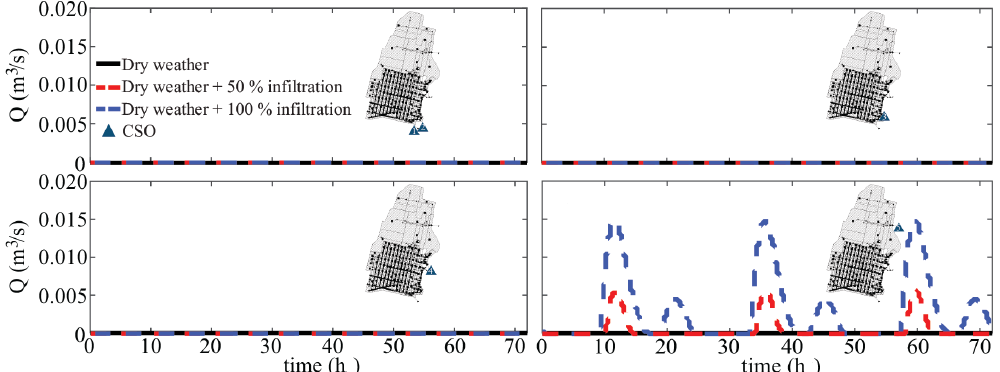
Figure 11. Flow rate as function of time at the five outfalls of the city of Hoboken in DWCs and DWCs with infiltrations. The simulated infiltration rate was set equal to 50% and 100% of the average dry-weather flow. The river level was fixed at 0.13 m above